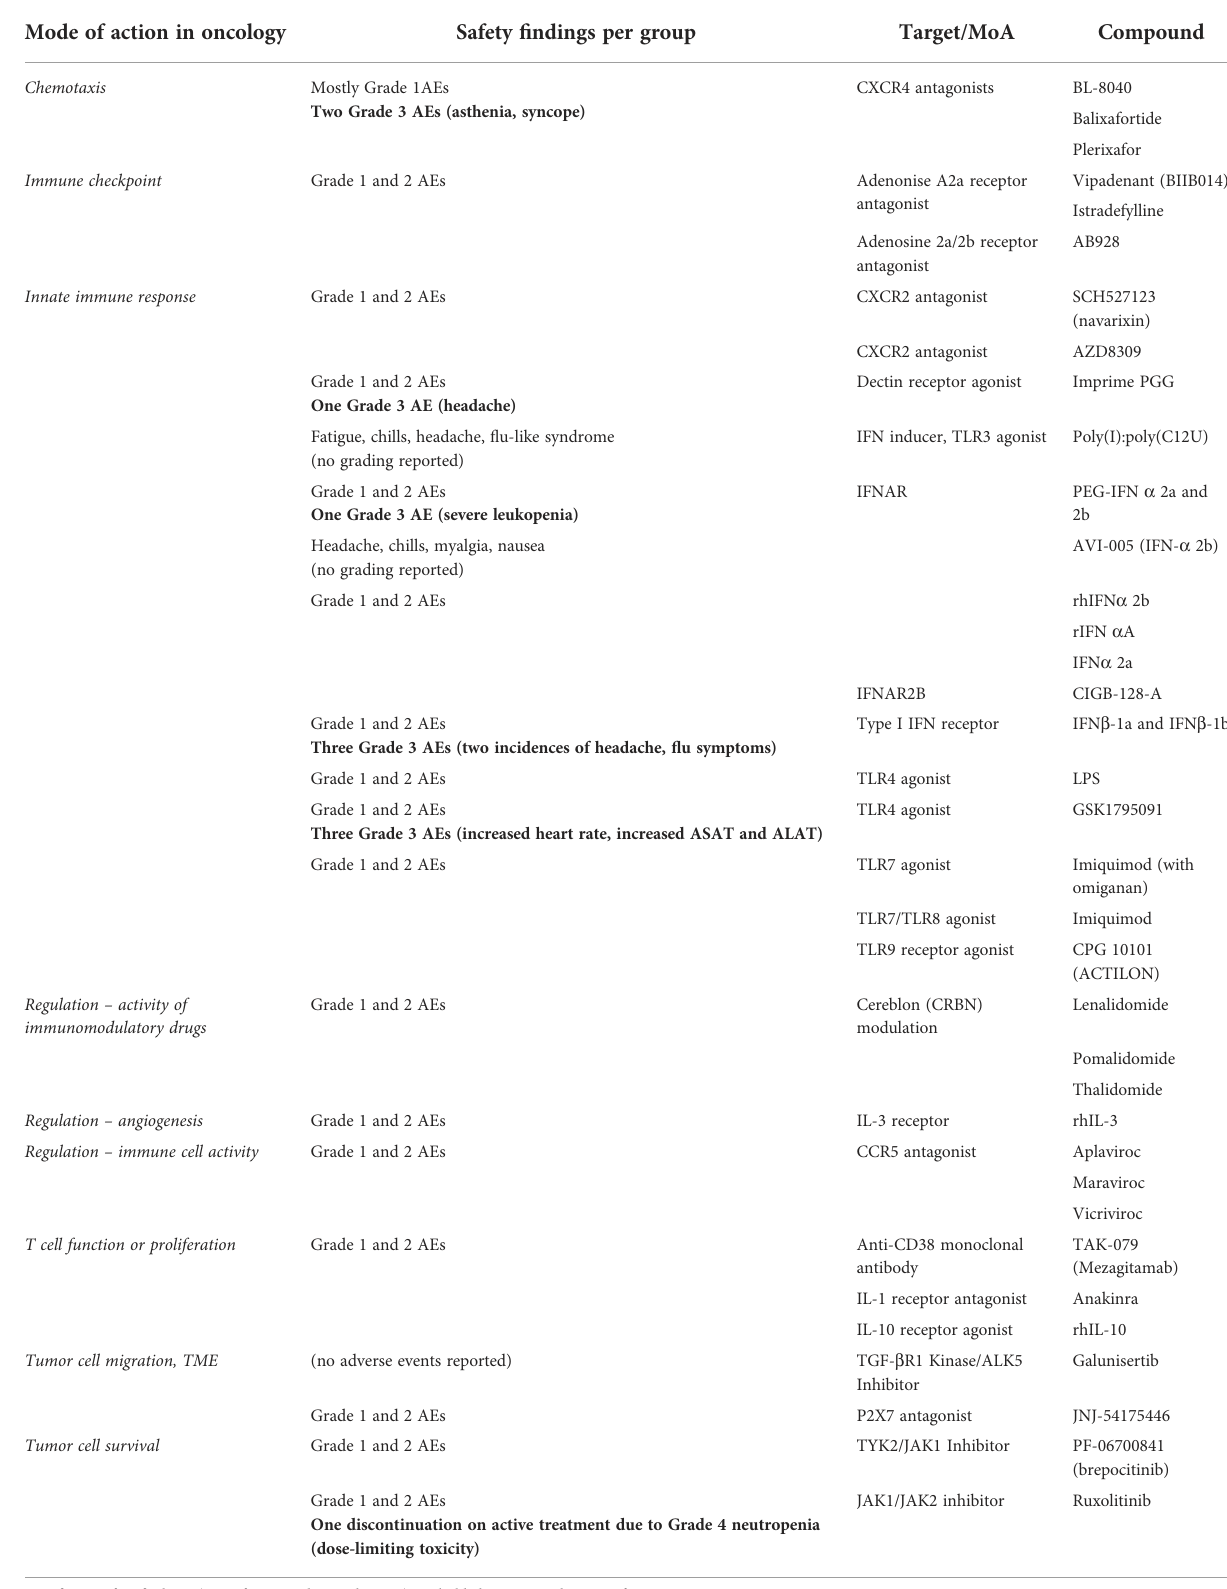
TABLE 3 Overview of safety fi ndings in healthy volunteer studies of compounds with proposed mode of action for